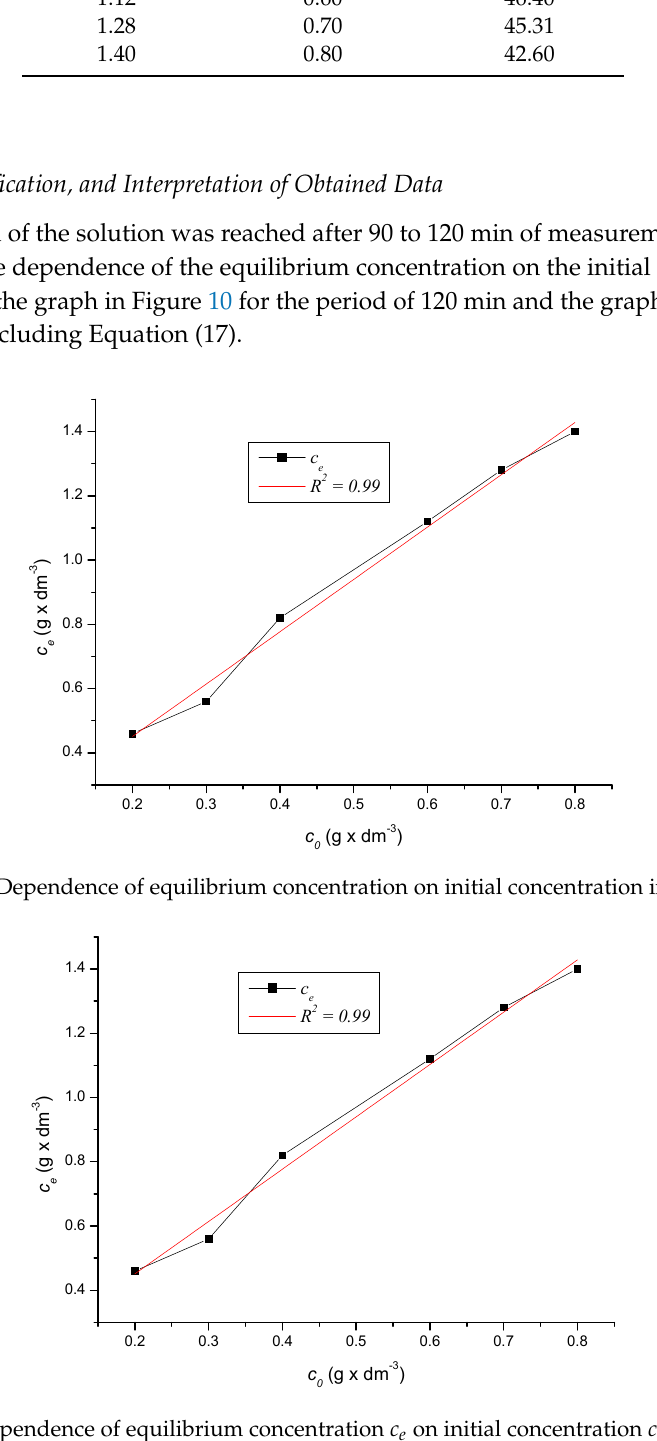
Figure 11. Dependence of equilibrium concentration c e on initial concentration c 0 in 150 min.